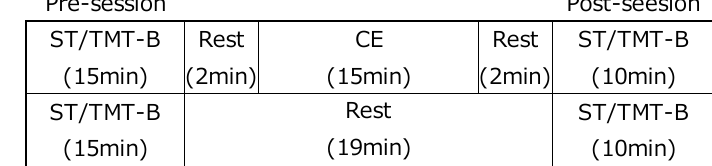
Figure 1. Experimental design (Study1). CE: Co-kara exercise. CON: control, ST: Stroop test, TMT-B: Trail-making test.